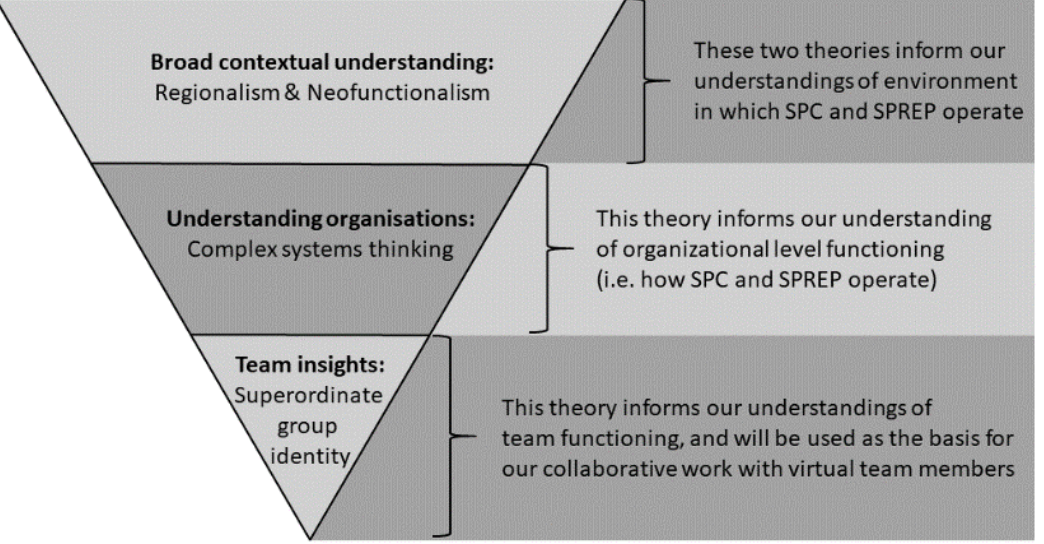
Figure 1. Links between theories (source: authors).